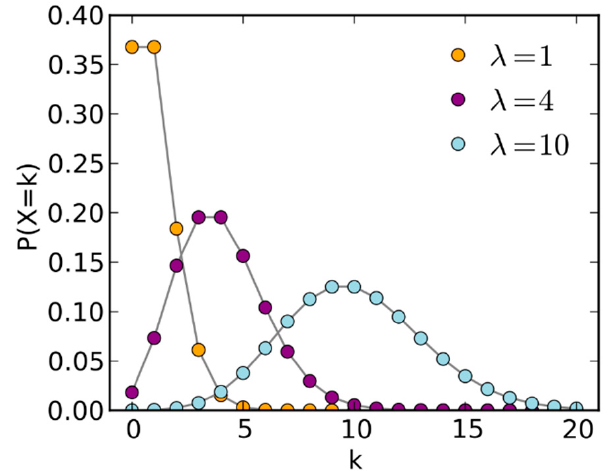
Figure 5. Poisson distributions with varying λ .